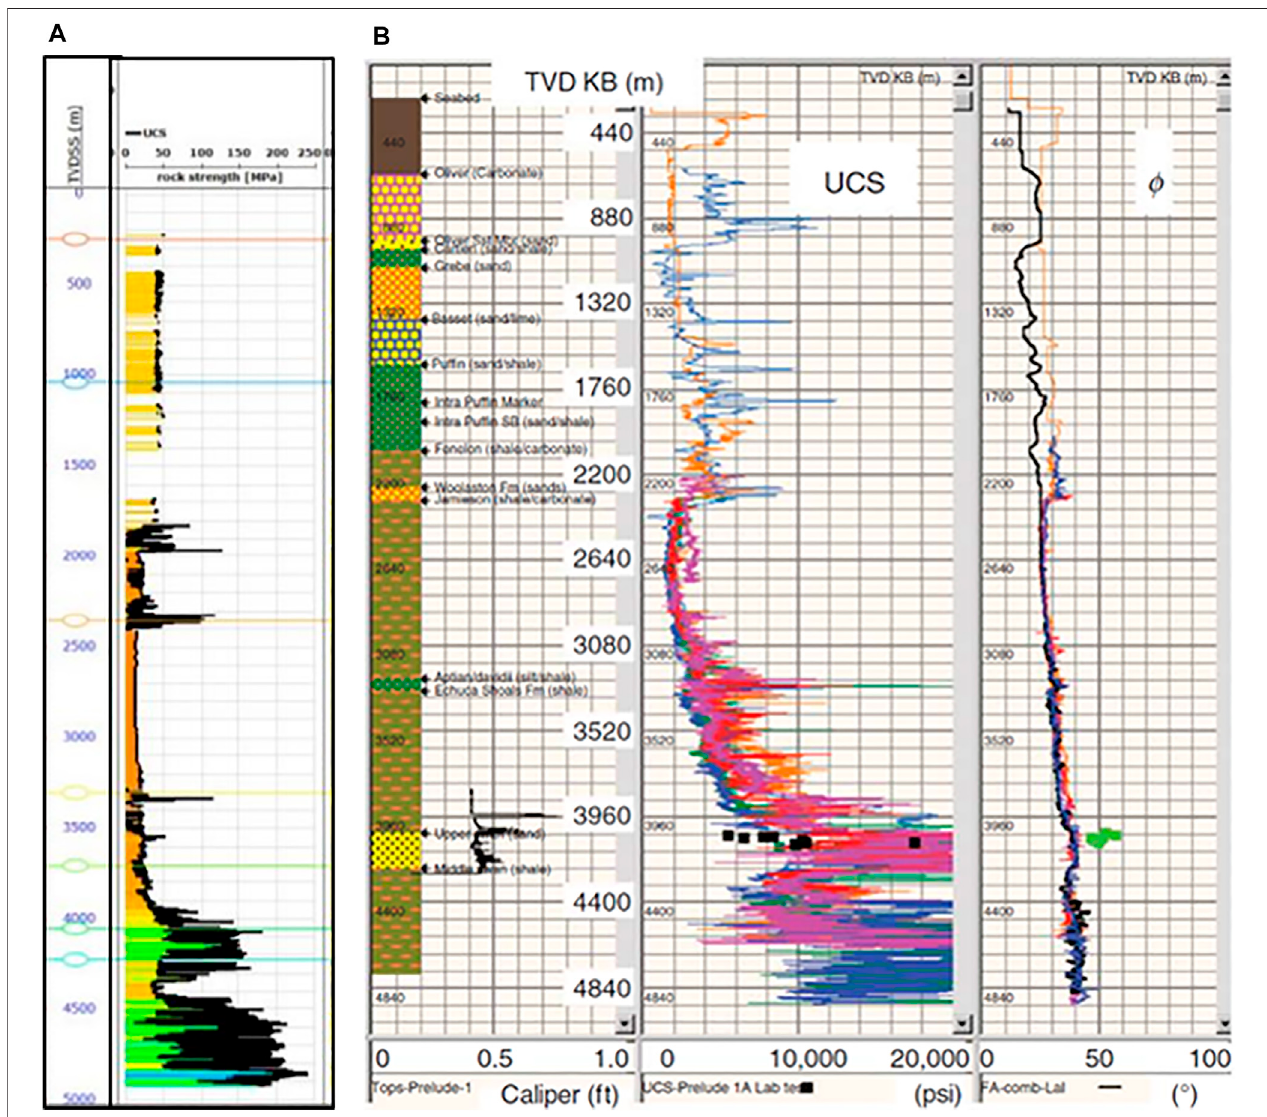
FIGURE 14 | Uniaxial compressive strength (UCS) and friction angle ϕ ′ pro fi les. (A) Ichthys deep-1 well (modi fi ed from Mandal et al., 2021). (B) Prelude wells (modi fi ed from Hansen et al., 2014).